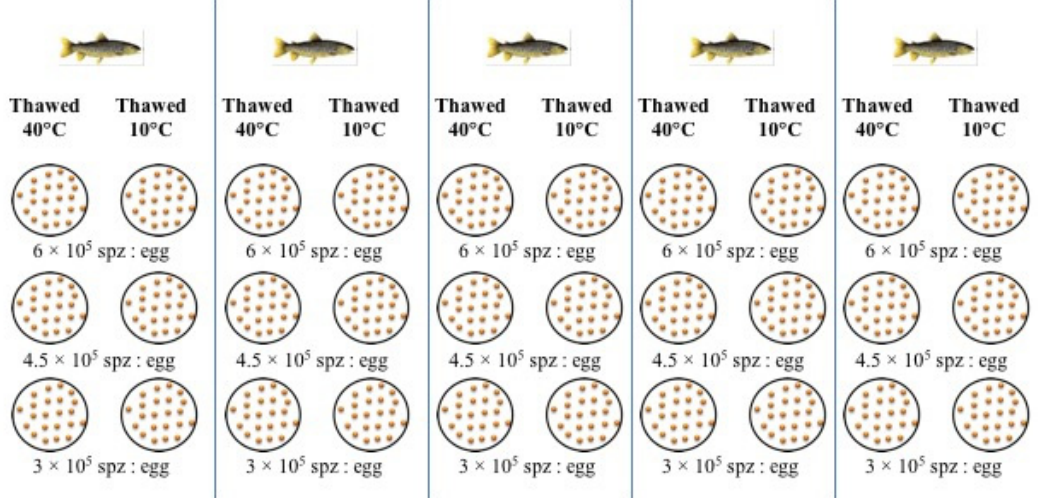
Figure 1. Fertilization scheme used to test the spermatozoa fertilization ability of five individual males thawed at 40 °C or 10 °C with sperm-to-egg ratios of 600,000:1, 450,000:1 and 300,000:1.